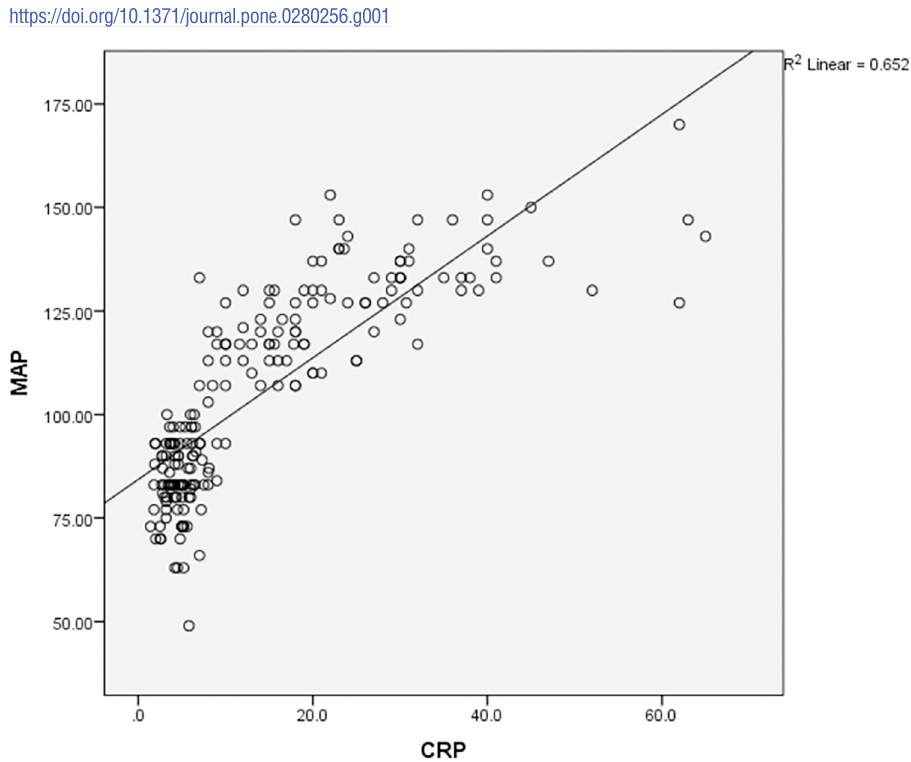
Fig 2. Correlation of C-reactive protein (CRP) and mean arterial pressure (MAP) in the study groups (mild and severe preeclampsia). MAP = 40 + 2 CRP (regression equation according to coefficients table) (t = 10.27, p < 0.001). https://doi.org/10.1371/journal.pone.0280256.g002 PLOS ONE | https://doi.org/10.1371/journal.pone.0280256 January 23,